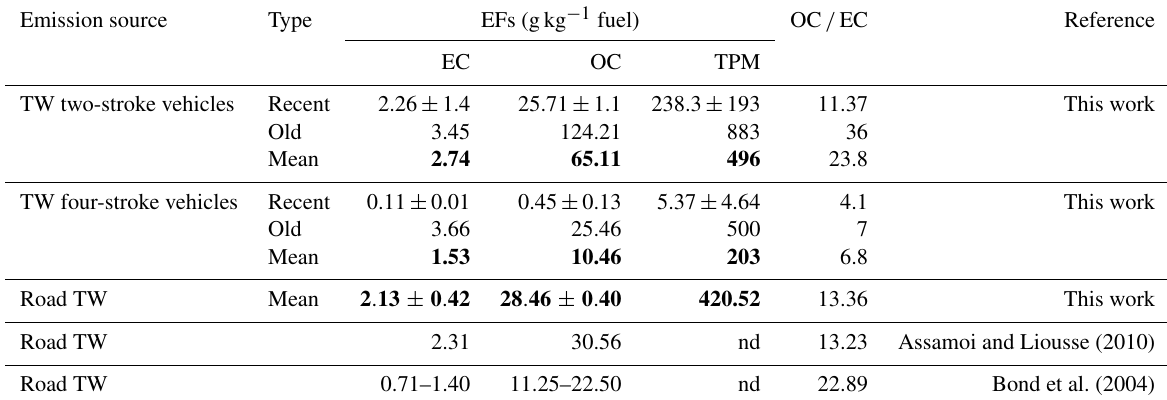
Table 3. EC and OC EFs for two-wheeled (TW) vehicles of our study and those of the literature (mean values in bold). Emission